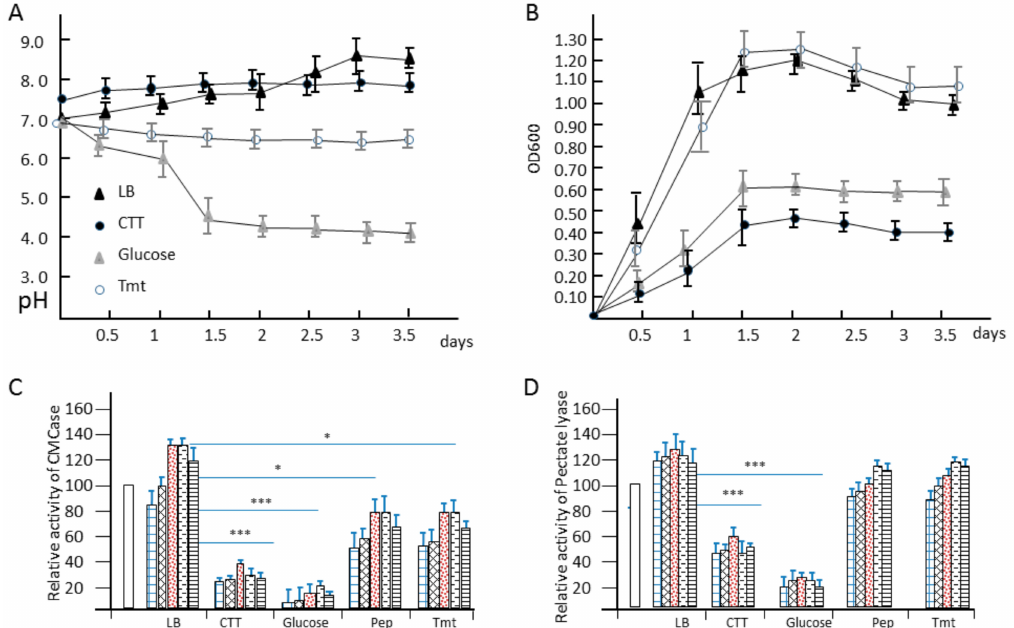
Figure 4. The growth and enzymatic activity of strain WS52 in di ff erent medium. ( A ) the pH change was measured in di ff erent medium; ( B ) the growth curve of strain WS52 were shown in OD600; ( C ) the CMCase activity were shown in relative activity in di ff erent medium; ( D ) the pectate lyase activity were shown in relative activity in di ff erent medium. Three asterisks indicate p < 0.01, one asterisk indicates p <